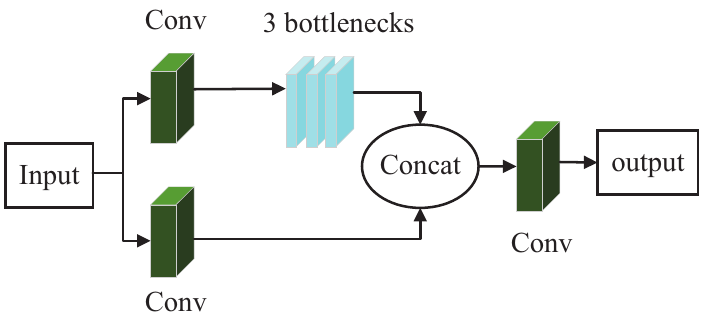
Figure 5. Schematic diagram of the first C3 module here